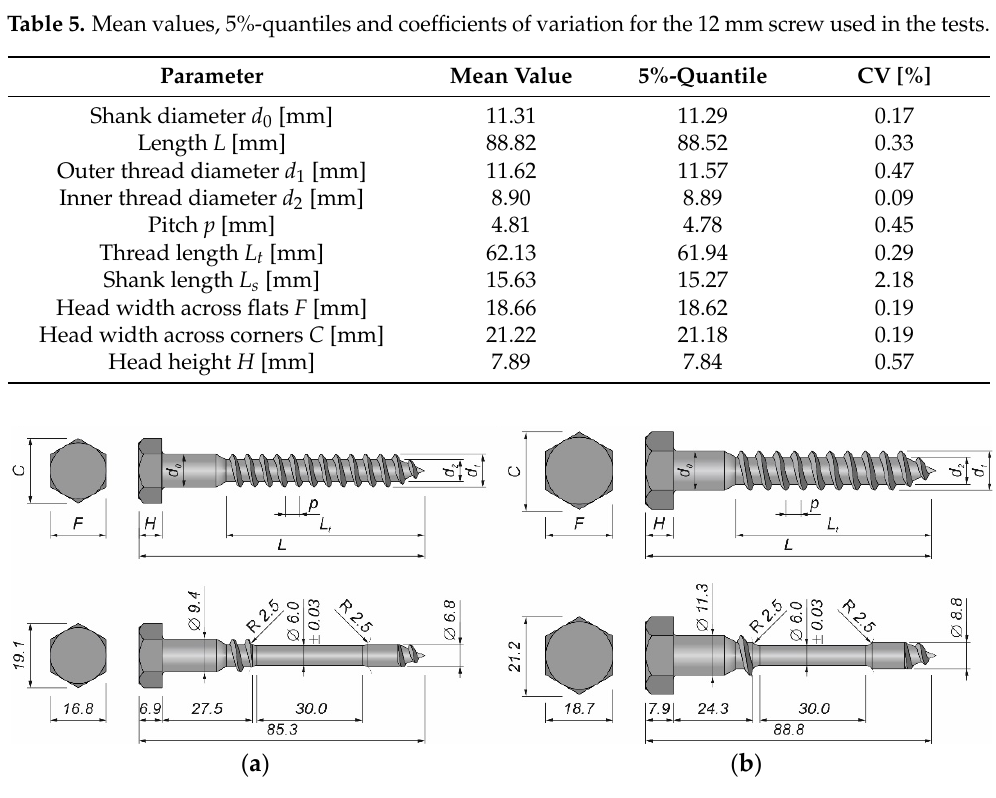
Figure 1. A shear connector: ( a ) 10 mm screw; ( b ) 12 mm screw.